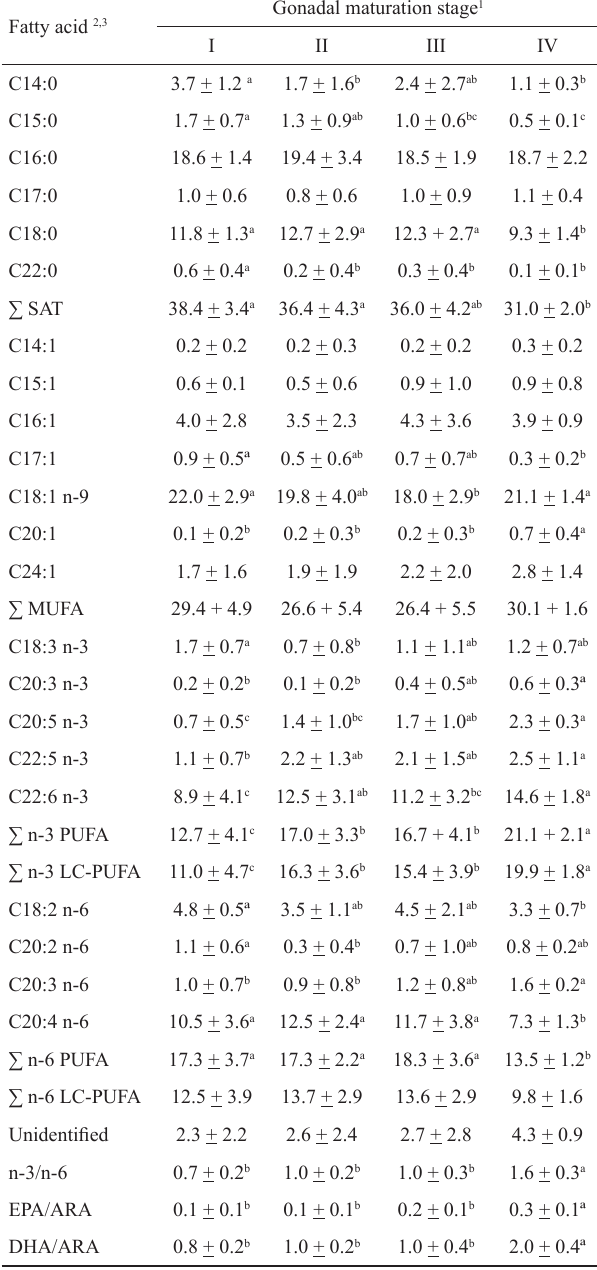
Table 2 . Fatty acid composition (% total fatty acids) from hamdia quelen ovaries caught in the upper rio Uruguay, grouped according to gonadal maturation stage. 1 According to Girhaldelli (2007): gonadal maturation stage (GMS) I = Immature (GSR < 0.4); GMS II Immature = Initial maturation (0.4 <GSR . <0.8), GMS III = Initial Mat Final maturation (0.8 < GSR < 2) and GMS IV = Final mat. Mature (GSR > 2). 2 Different letters within the same Mature row represent significant differences, with a significance level of 5%. 3 SFA = saturated fatty acids, MUFA = monounsaturated fatty acids, PUFA = polyunsaturated fatty acids, LC PUFA = polyunsaturated fatty acids long- chain (>20 carbons). The values are average + DST. Fig. 2. Relationship between unsaturated and saturated 1 fatty acids in Rhamdia quelen ovaries collected from natural environment and grouped according to their gonadal maturation stage. UFA/SFA = (monounsaturated fatty acids + polyunsaturated fatty acids)/ saturated fatty acids.